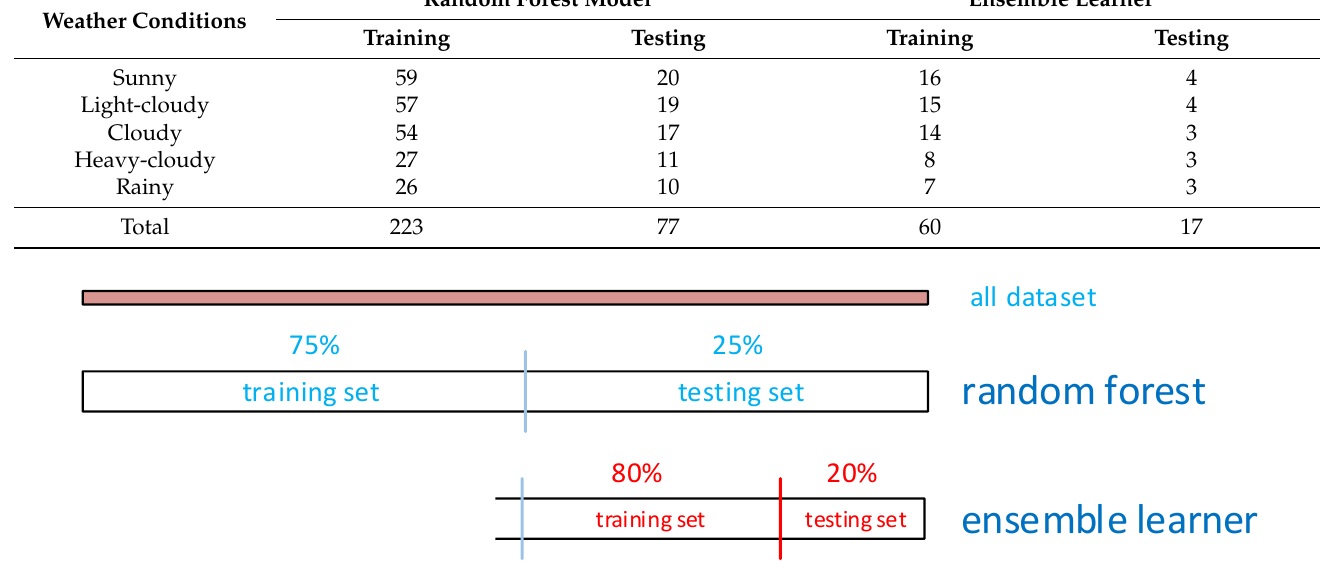
Figure 7. Details of the data preparation procedure.